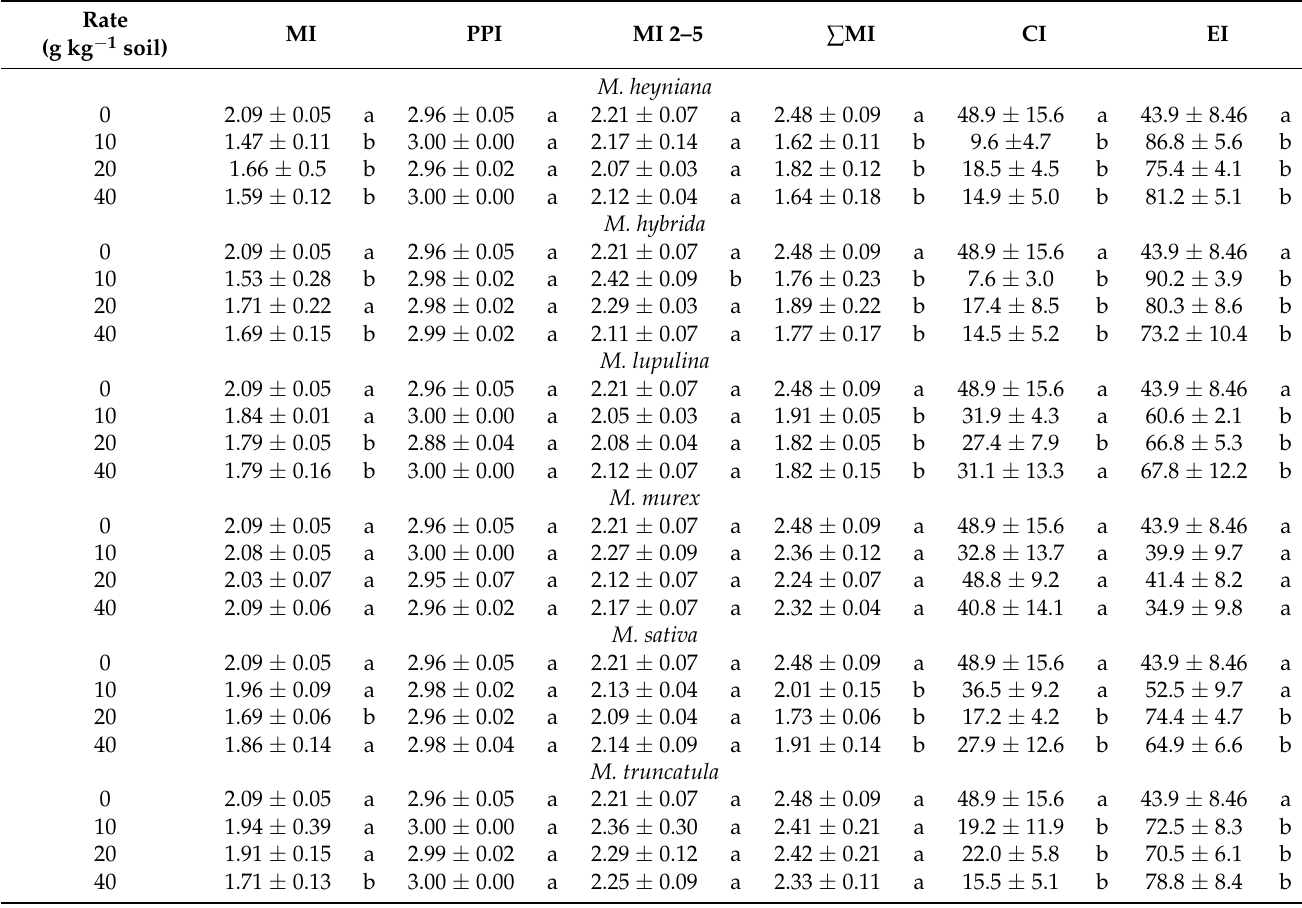
Table 1. Soil food web descriptors in soil amended with dry biomasses from six Medicago species.